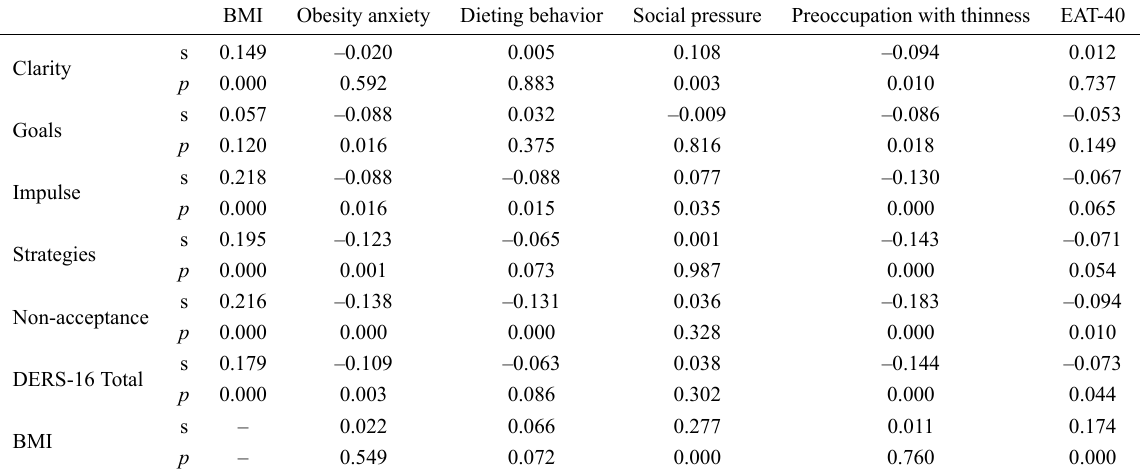
Table 4. The relationship between the total and sub-factor scores of the students and the BMI values and the total and